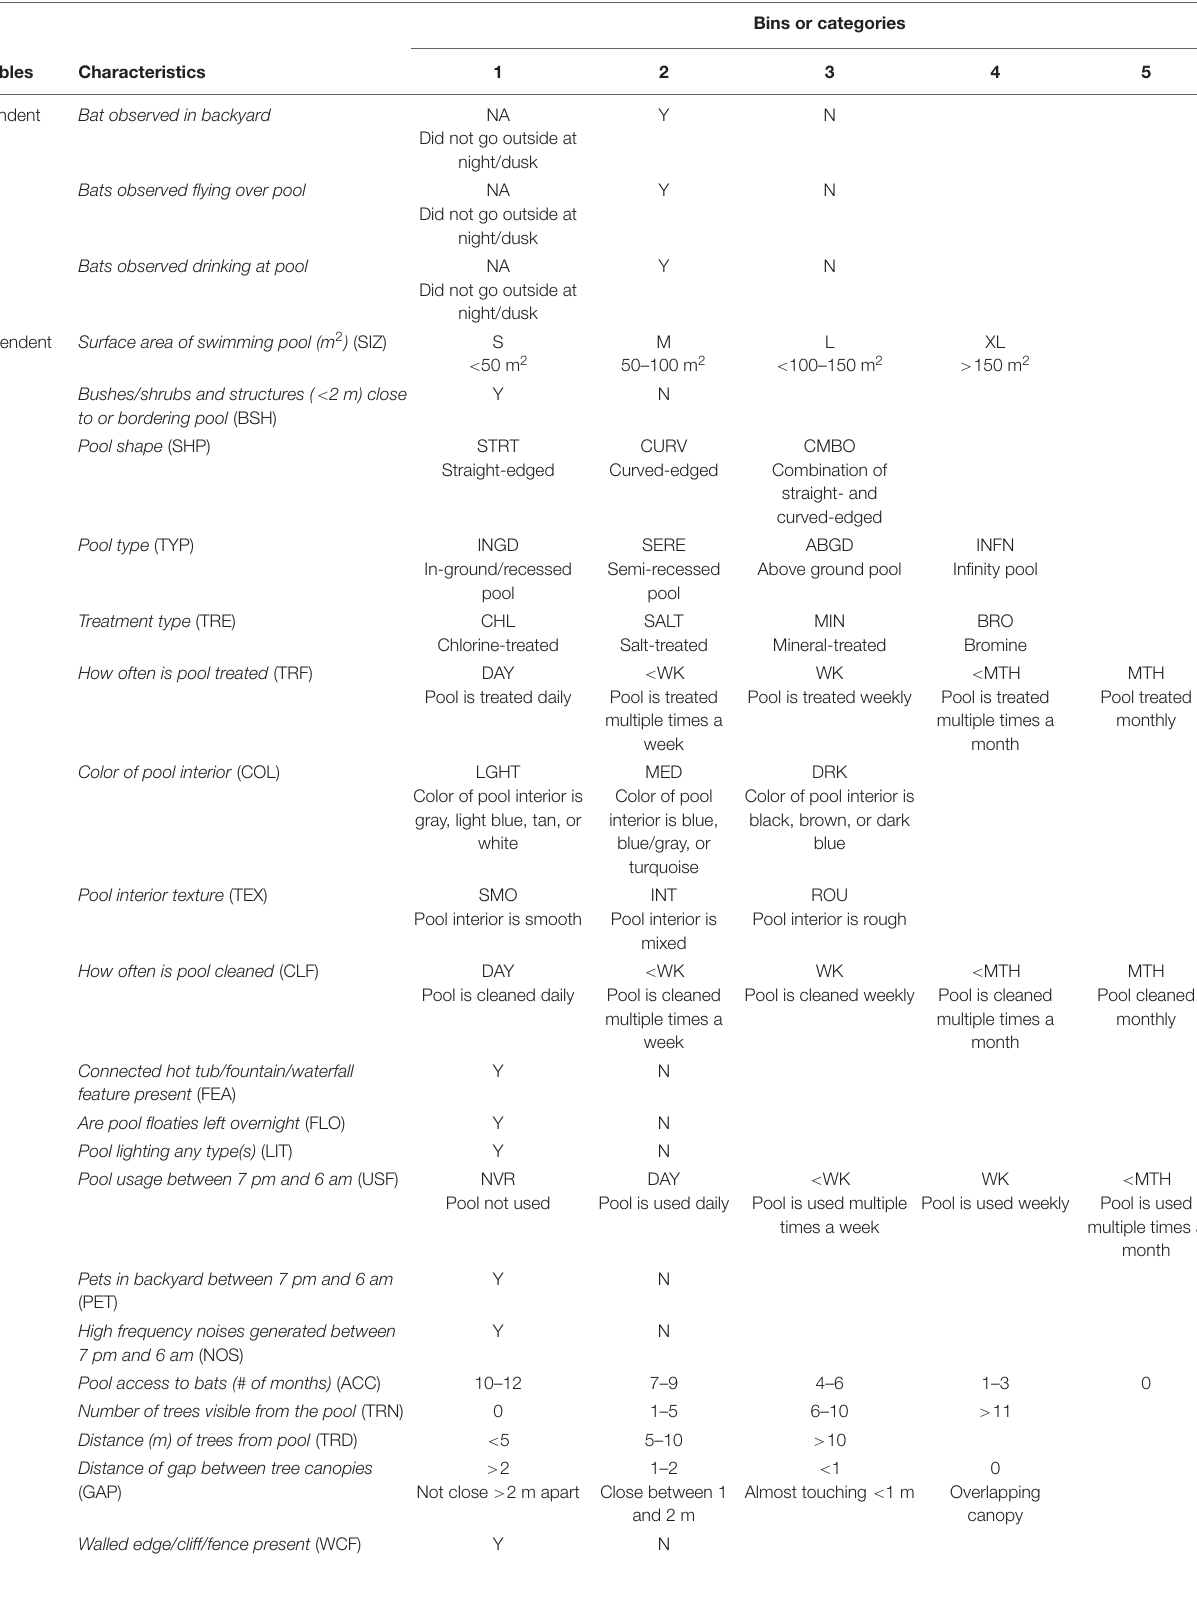
TABLE 1 | Dependent and independent variables identified in the swimming pool